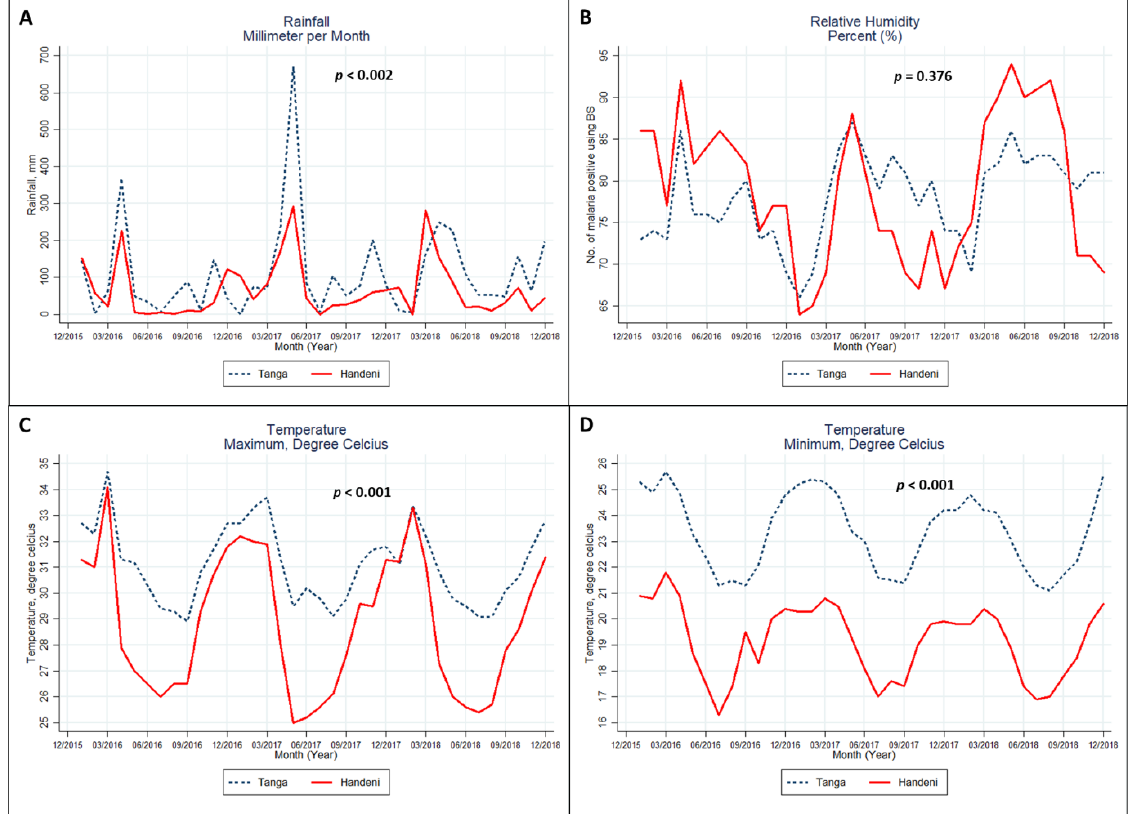
Figure 1. Monthly rainfall ( A ), humidity ( B ), maximum temperature ( C ), and minimum temperature ( D ) from 2016 to 2018 in Tanga, Tanzania. Note : multilevel linear mixed-effects regression—with levels 1 and 2 being month and year, respectively—was used to test the trend differences.